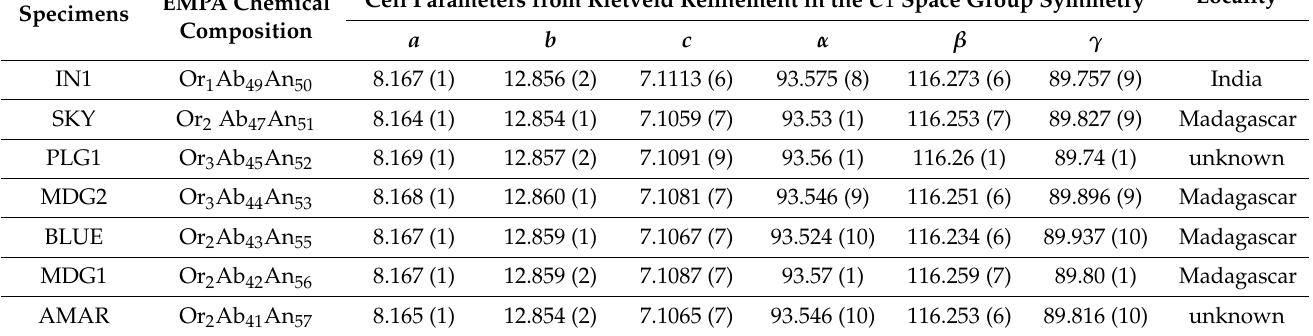
Table 6. Chemical composition and cell parameters of labradorite specimens, in Å for the cell dimensions and degrees for the cell